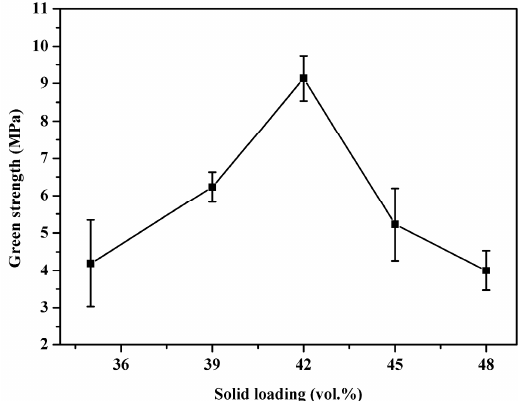
Figure 9. Effect of solid loading on the flexure strength of the dried KNN green bodies. The error bars represent the standard deviation values, while the points represent the average values.